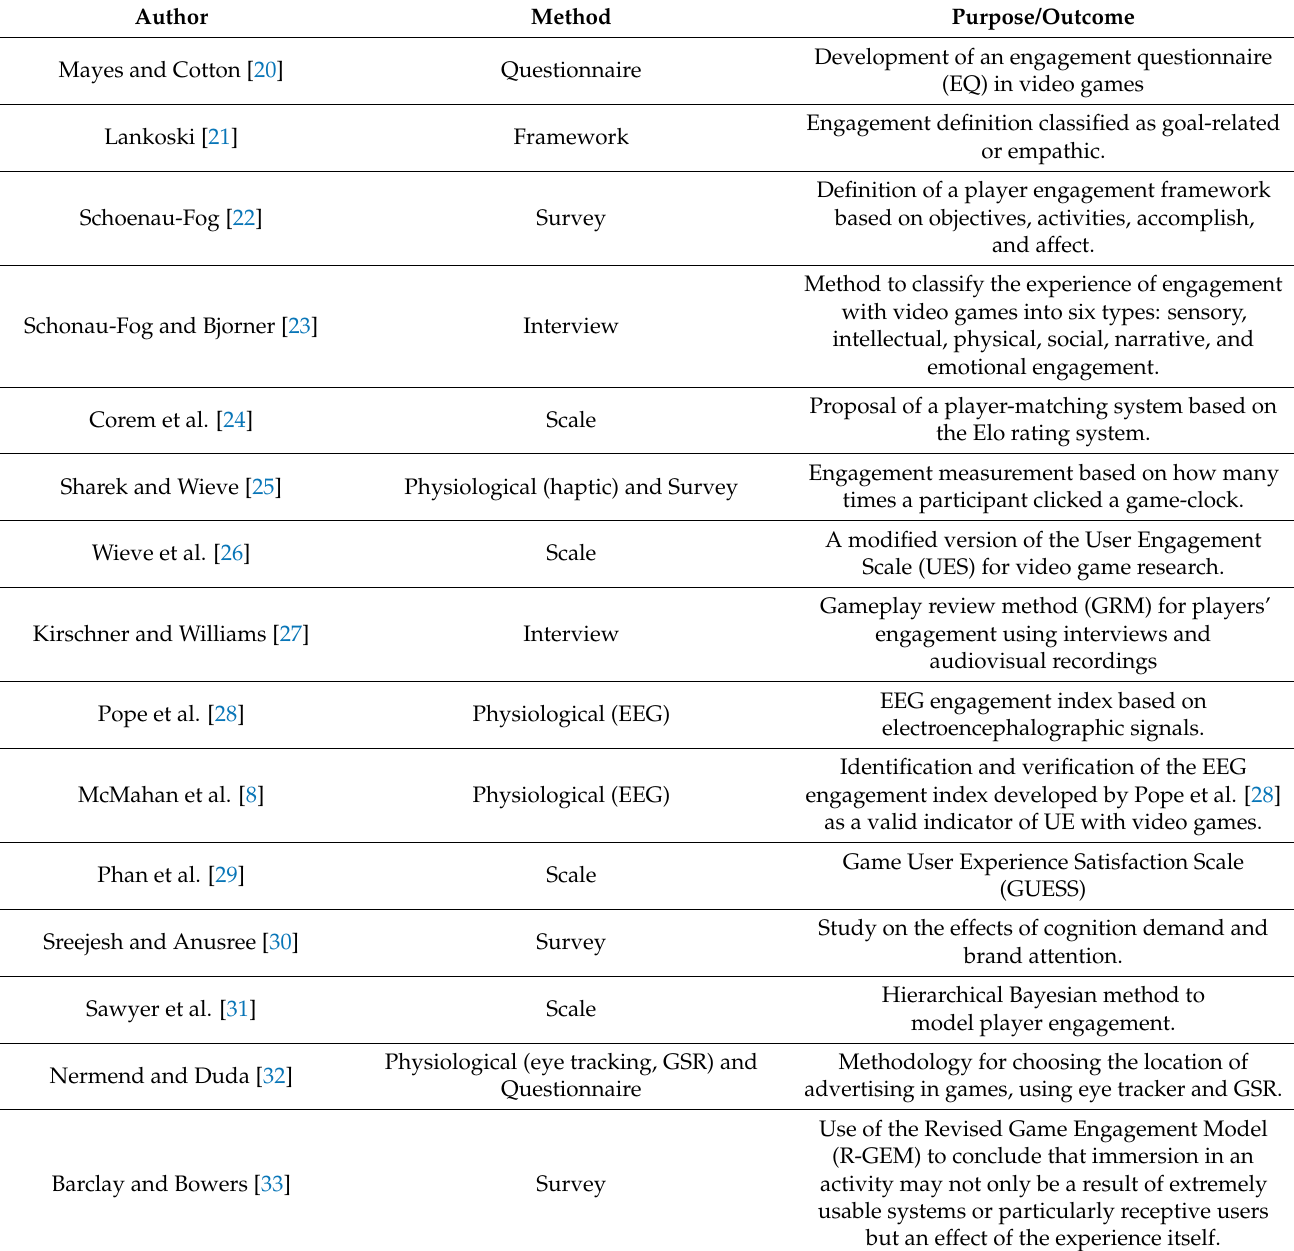
Table 1. UE analysis in video